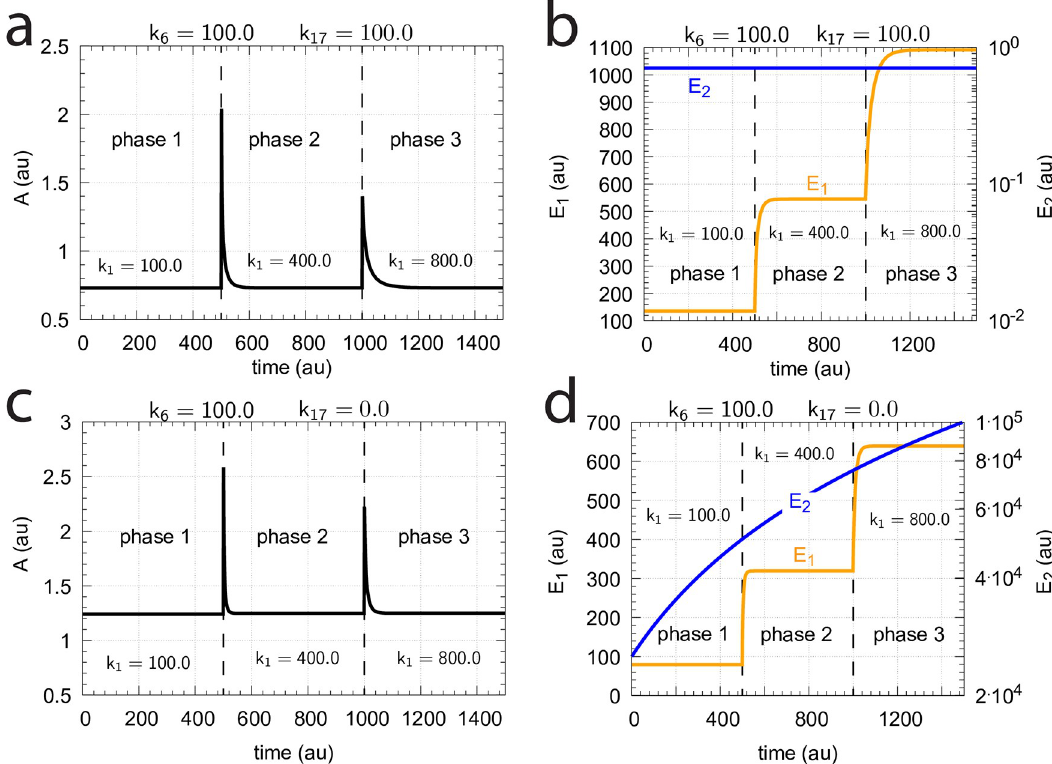
Fig 49. Demonstration of the homeostatic behavior of A (scheme Fig 48) when k 6 =100.0 and k 17 =100.0 (panels a and b) or k 17 =0.0 ss (panel c and d). The behavior is analogous to that shown in Fig 47. Step-wise perturbations are applied with values k 1 =100 (phase 1), k 1 =400 (phase 2), and k 1 =800 (phase 3). Other rate constants as in Fig 45. The linear increase of E 2 is seen as a concave line due to the logarithmic scale of the E 2 -axis. v max =50 (Eq 151). Initial concentrations, (a) and (b): A 0 =0.7309, E 1,0 =1.36 × 10 2 , E 2,0 =7.08 × 10 − 1 , Ez 0 =2.15 × 10 − 9 , (E 2 � Ez) 0 =2.924 × 10 − 7 , (Ez � � E 1 ) 0 =2.924 × 10 − 7 , and Ez � =4.13 × 10 − 7 . Initial concentrations, (c) and (d): A 0 =1.242, 0 E 1,0 =7.95 × 10 1 , E 2,0 =2.52 × 10 4 , Ez 0 =1.97 × 10 − 11 , (E 2 � Ez) 0 =4.97 × 10 − 7 , (Ez � � E 1 ) 0 =4.97 × 10 − 7 , and Ez � =6.25 × 10 − 9 . 0